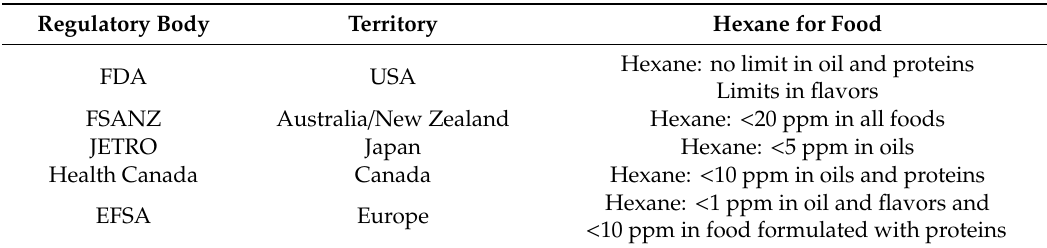
Table 9. Di ff erent territories, di ff erent